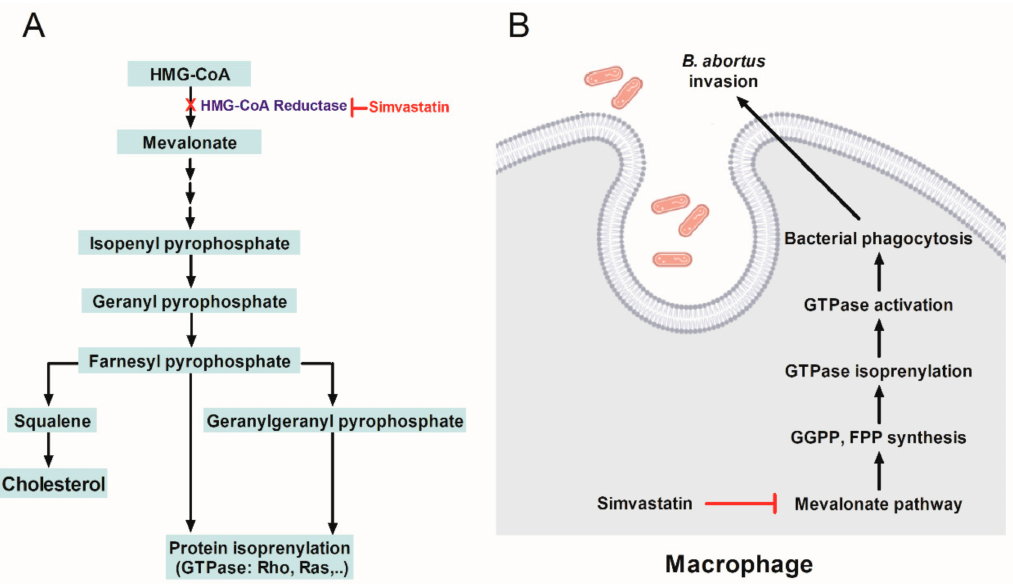
Figure 6. Schematic of mevalonic pathway and illustration of the inhibition effect of simvastatin on Brucella invasion through suppression of mevalonate pathway. Simvastatin inhibits the conversion of HMG-CoA to mevalonate, leading to the inhibition of GGPP and FPP synthesis, which regulates the prenylation of some GTPase such as Ras and Rho families ( A ). Inhibiting GTPase synthesis caused by simvastatin treatment affects the activation of GTPase lead to the reduced B. abortus internalization into RAW 264.7 cells ( B ). Abbreviations: HMG-CoA: 3-hydroxy-3-methylglutaryl coenzyme A; FPP: farnesyl pyrophosphate; GGPP: geranylgeranyl pyrophosphate.